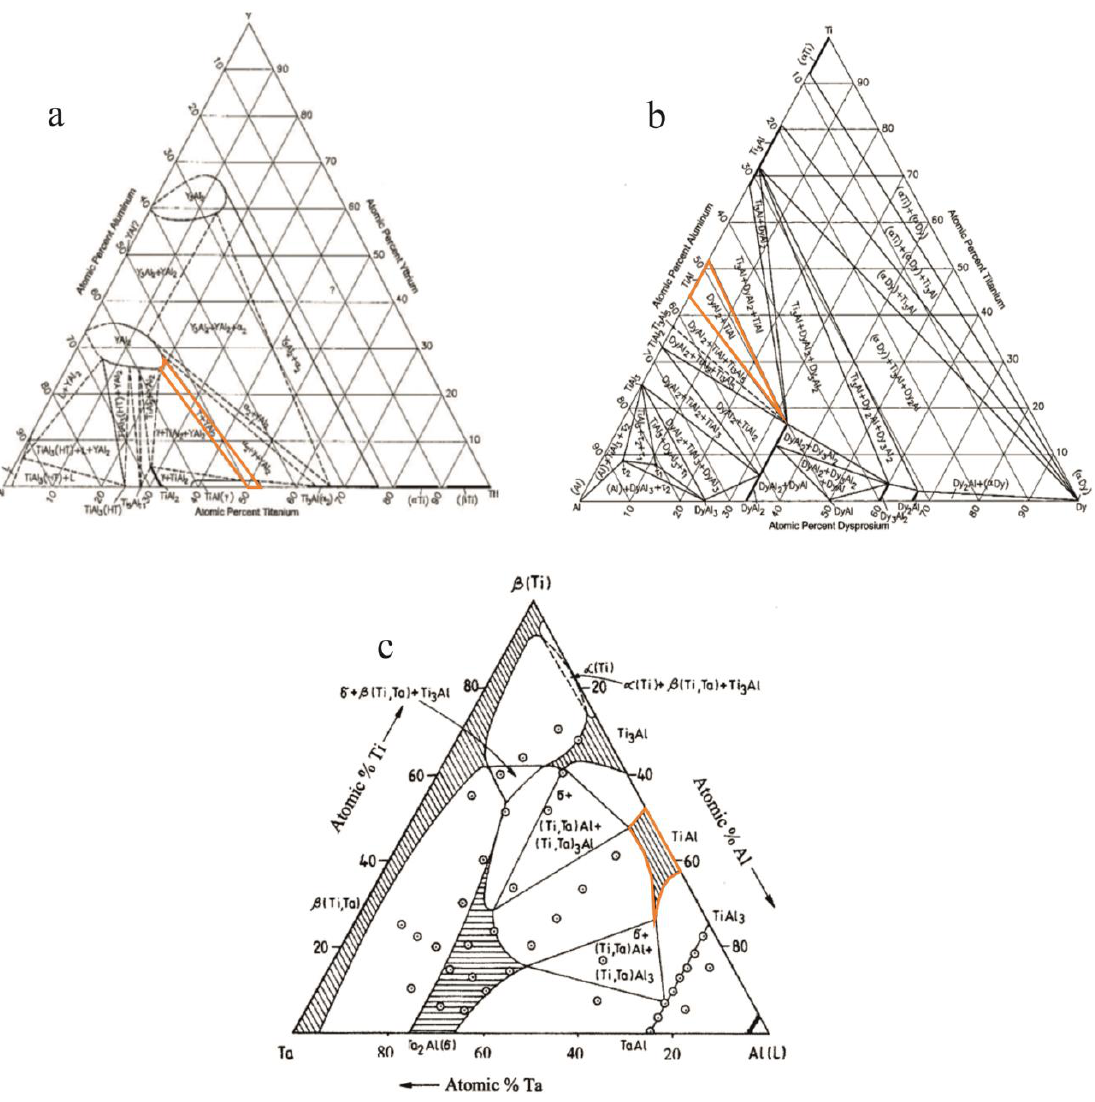
Table 8. Crystallographic data of phases in the TAY system.